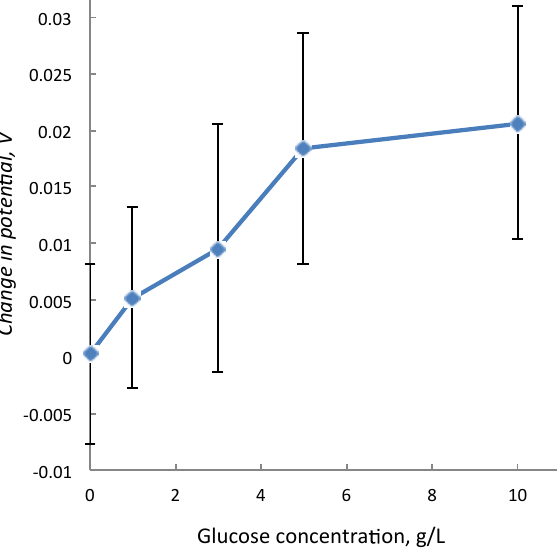
Figure 3. Surface potential changes of PNIP-B-30 modified electrode as a function of the glucose concentration investigated at 25 °C. Data are expressed as averages + S.D. ( n =